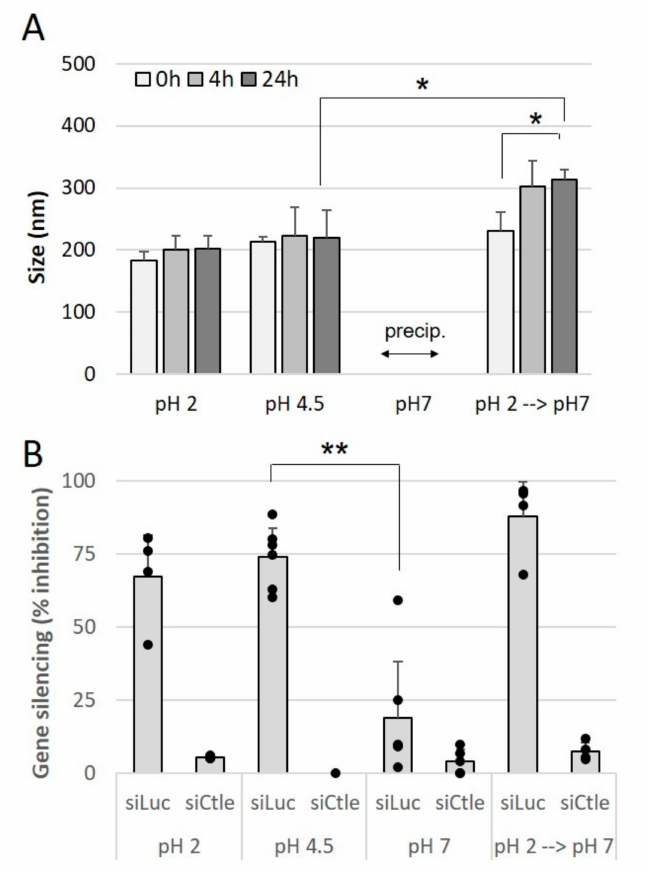
Figure 3. Effect of pH on size and gene-silencing efficacy of siRNA lipoplexes. siRNA lipoplexes were prepared at pH 2, 4.5 or 7, or prepared at pH 2 and incubated for 1 h at pH 7. A —Size measurements were performed immediately after preparation, and 4 h and 24 h after